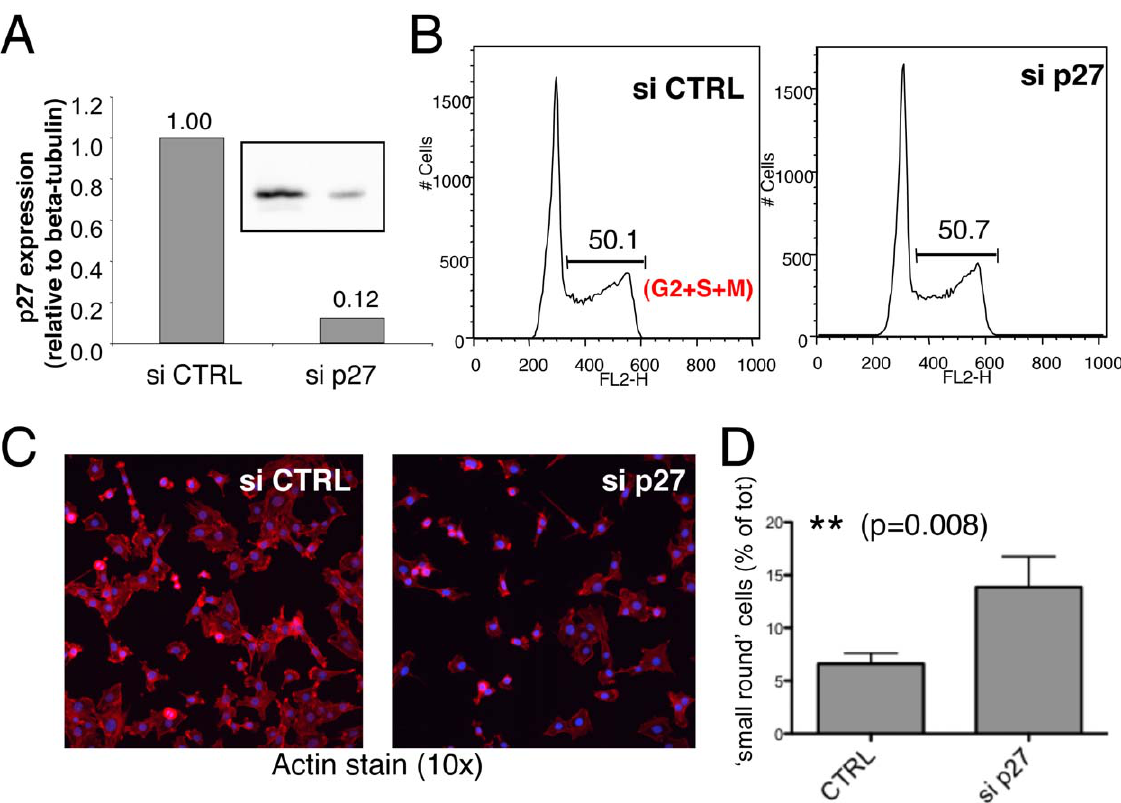
Figure 7. Knockdown of the miR-221 target p27 Kip1 does not recapitulate the composite effects of miR-221 expression. A ) 3T3 cells were transfected with siRNA oligonucleotides against p27 Kip1 (si p27) or with a non-targeting control (si CTRL). 48–72 h later cells were collected and lysed for Western blot analysis. Shown is the quantification (against b -tubulin, used as loading control) of one representative blot; the actual blot for p27 Kip1 is shown in the inset. Efficiency of transfection ranged between 50–70% depending on the experiment, with a downregulation of protein expression as assessed by Western blot that ranged widely between 0.05–80% of the levels of control, with the latter case (highest expression, minimal knockdown) showing no phenotypic effect. B ) 3T3 cells as in A) were trypsinized to single-cell suspension, fixed in ethanol and stained with propidium iodide for cell-cycle analysis. C ) Cells as in A) were seeded on coverslips and allowed to adhere overnight prior fixation with 4% paraformaldehyde and staining with phalloidin-AlexaFluor-594. Nuclei were counterstained with DAPI (blue). D ) Quantification of the percentage of ‘small, round’ cells observed in an experiment as in C). For each sample, 8 random fields were counted, at a magnification of 10x.